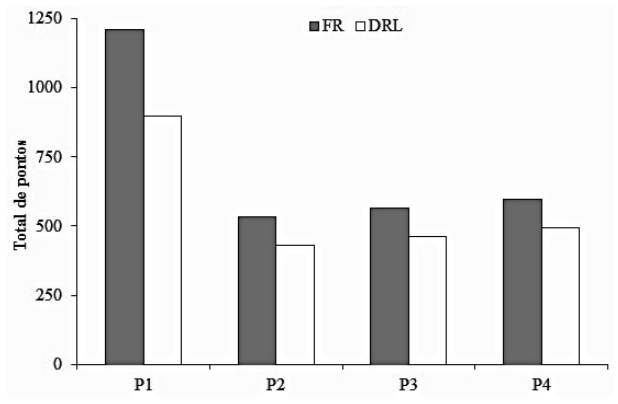
Figura 4. Total de pontos obtidos por participante nos componentes FR e DRL durante as Fases 1, 2 e 3.